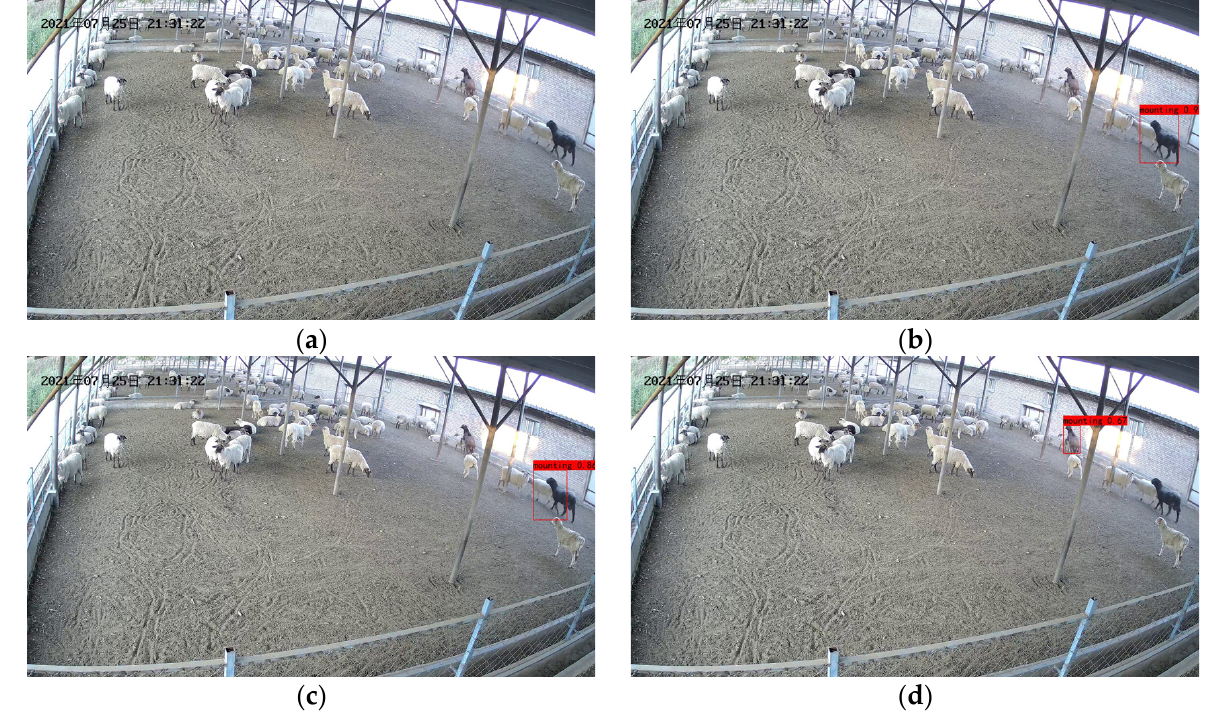
Figure 12. False identification results of the model: ( a ) Original image; ( b ) YOLO v3 recognition results; ( c ) YOLO v4 recognition results; ( d ) Identification results of our model. The Chinese characters in the upper left corner of the image are the date of the video recording, in order of year, month, and day.